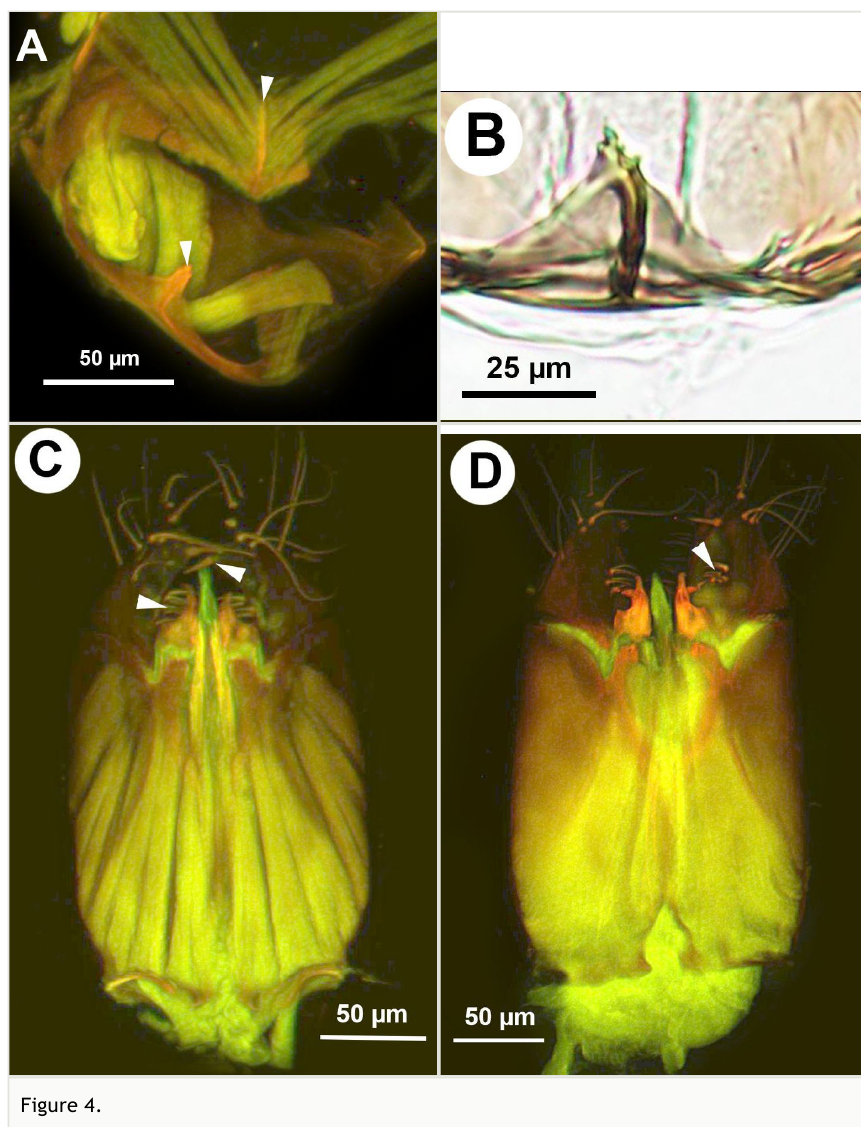
Figure 4. Confocal Laser Scanning Microscope (CLSM) image of male genitalia. a : CLSM image showing the notch of cupula and muscle attachment apodeme of cupula. b : Bright fi eld image of cupula notch. c : Male genitalia in ventral view, arrows indicate setal arrangement along proximal edge of harpe. d : Male genitalia in dorsal view, arrows indicating setal patch of